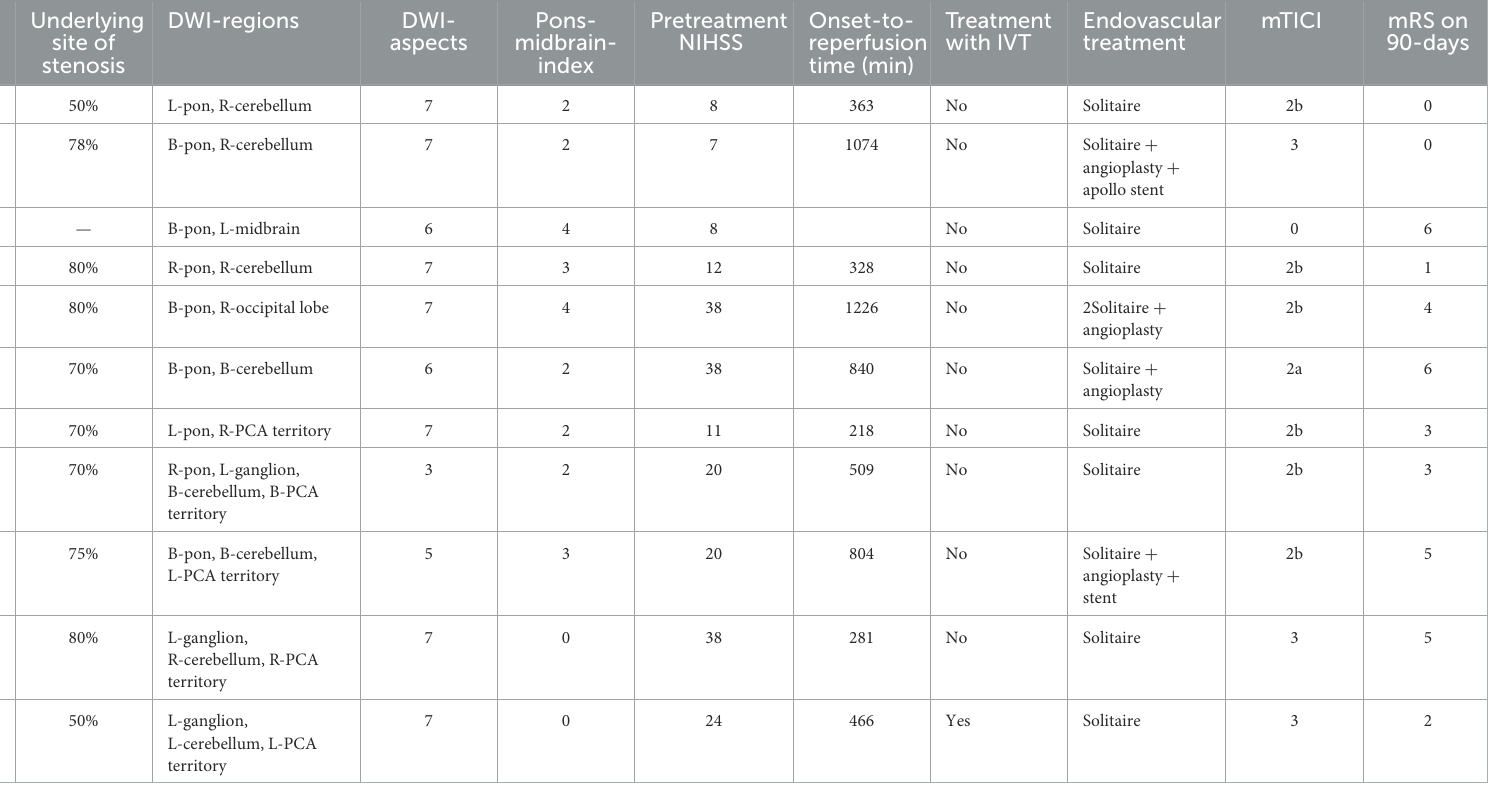
TABLE 1 Procedural-associated characteristics of the patients. Patient